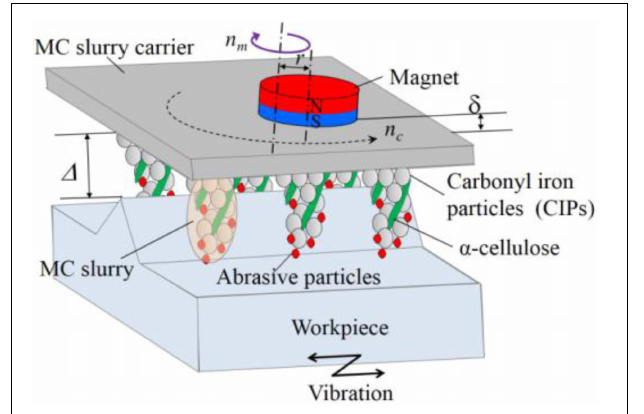
FIGURE 10 | The magnetic compound (MC) slurry polishing principle (Wang Y. L. et al.,